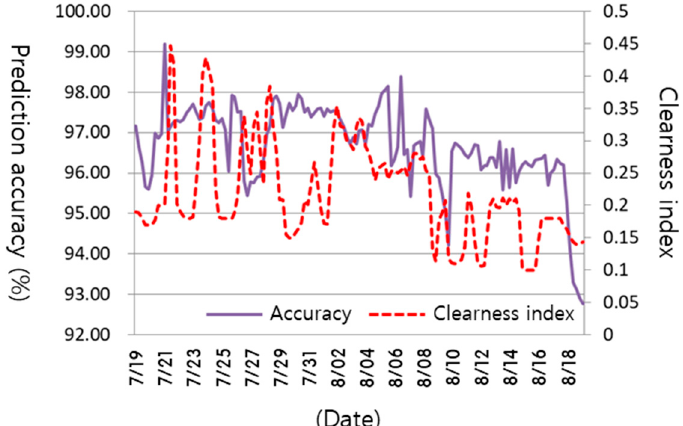
Figure 18. Variations of the prediction accuracies for the daylight illuminance on the workplane and clearness index.